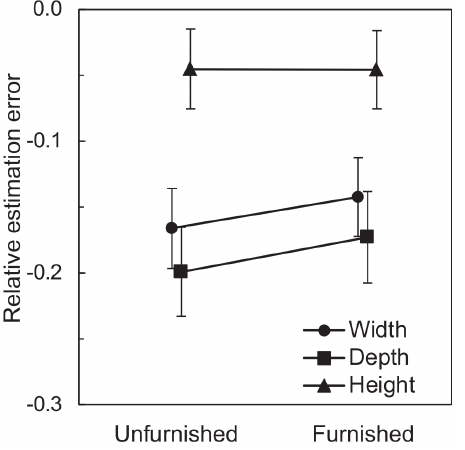
Figure 8. Experiment 2: Mean relative estimation errors of the three room dimensions as a function of furnishing. Error bars show 6 1 SEM of the 39 subjects in each condition.